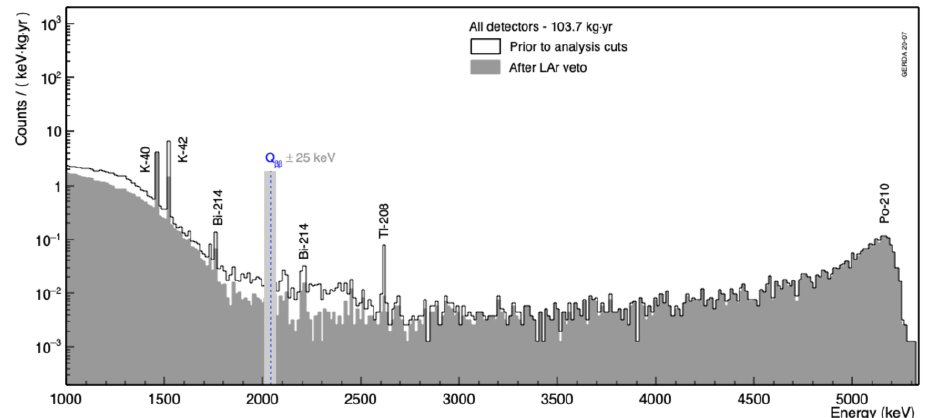
Figure 20. The impact of the LAr cut on the 103.7 kg are